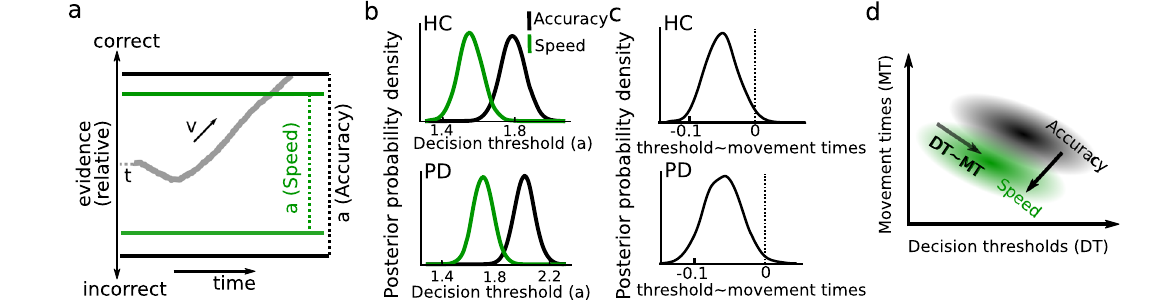
Fig. 2 | Hierarchical drift-diffusion modeling (HDDM). a The main parametersof themodelarethenon-decisiontime t ,the driftrate v , and the decisionthreshold a determining when sampled sensory evidence(gray trace) results in a choice thatis correct (upper boundary) or incorrect (lower boundary). Faster decision during speed pressure can be implemented through a reduction of a (shown in green). B Both Parkinson ’ s disease (PD) patients and healthy controls (HC) had lower decisionthresholdsafterspeedcomparedtoaccuracytrials. C Posteriordensityfor